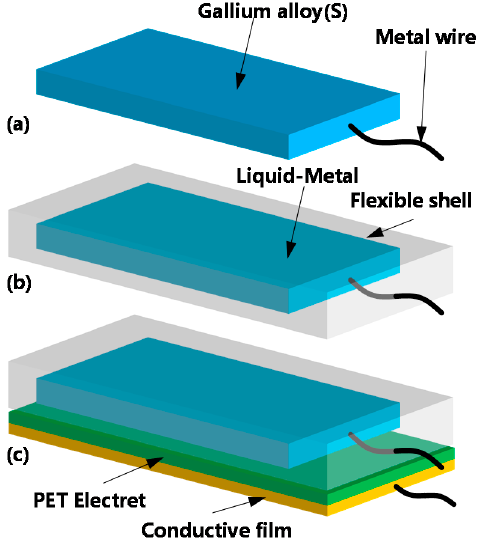
Figure 5. Schematic diagram of the fabrication process of the designed energy harvester. ( a ) molding and low-temperature curing of liquid gallium alloy electrode; ( b ) secondary molding of dragon-skin silicone rubber; ( c ) assembly of the designed energy harvester.